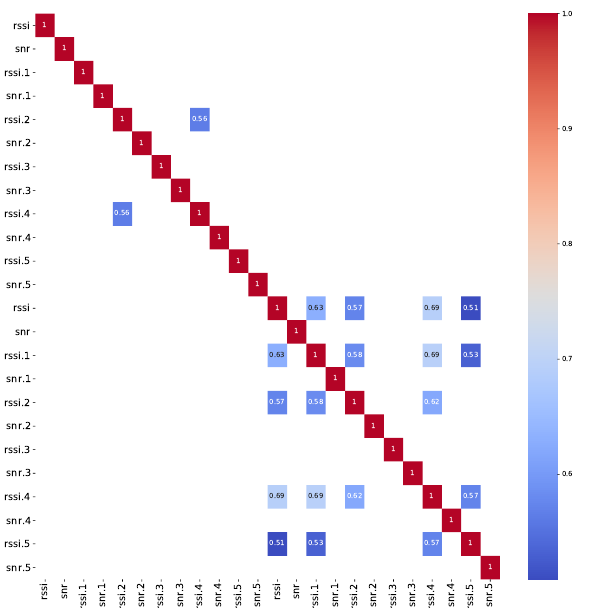
Figure 15. Data correlation for RSSI and SNR values for ROOM A507 and location points 10 and 11 for SF11.